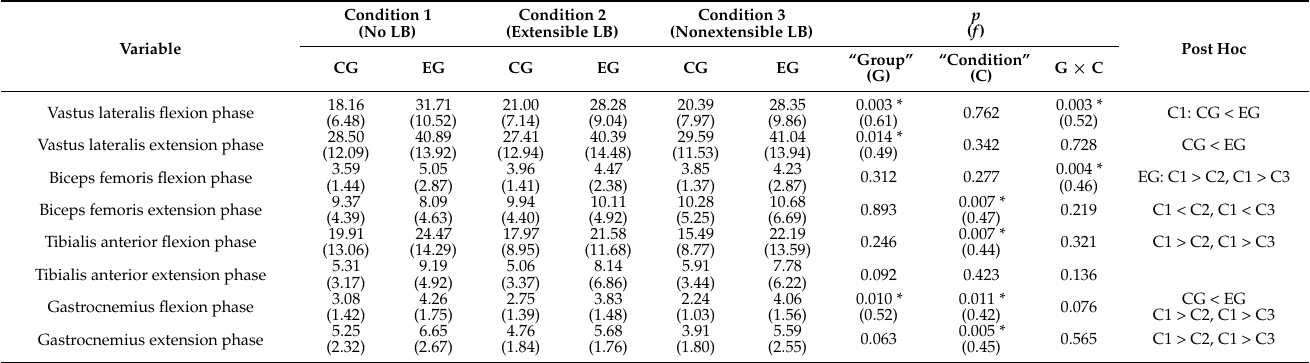
Table 3. Analysis of muscle activity variables of the sit-to-stand motion according to the experimental conditions